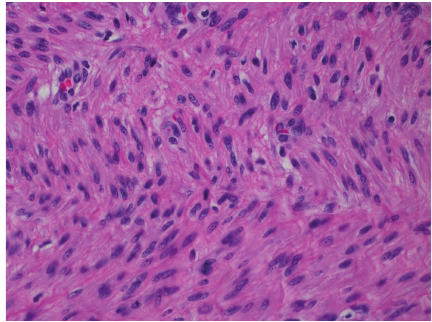
Figure 2: Medium power magnification H&E stain of round ligament leiomyoma showing spindle cells with “cigar shaped” nuclei and “herringbone” pattern often seen in smooth muscle tumors. No evidence of perinuclear vacuolization, hypercellularity, or cytological atypia.